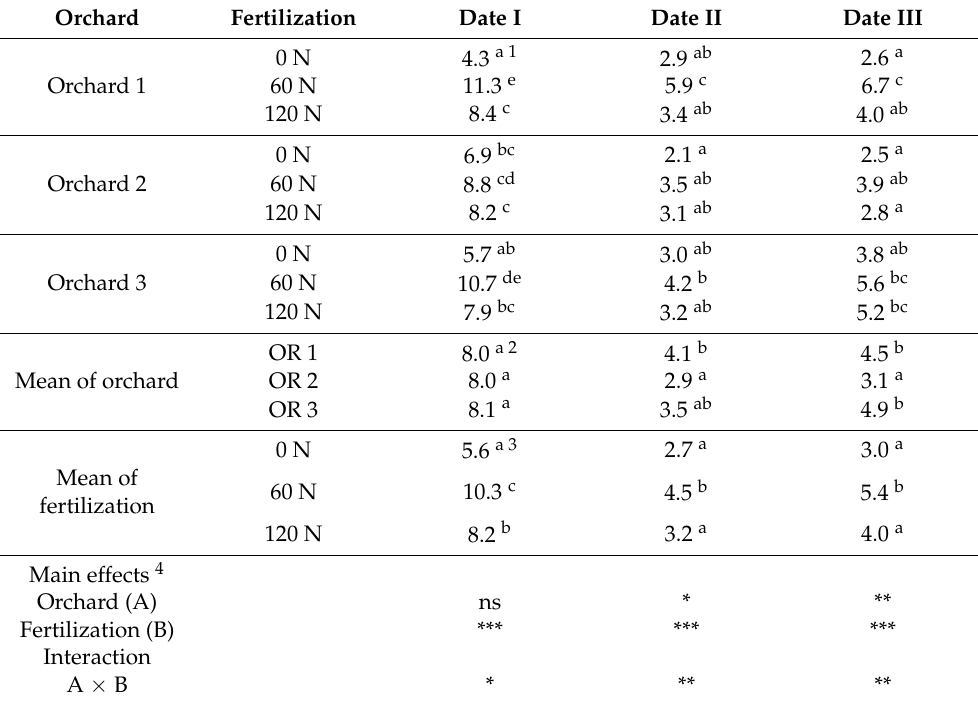
Table 2. Influence of nitrogen fertilization on the activity of dehydrogenases in 2008–2010 (ADh cm 3 H 2 24 h − 1 kg − 1 DW